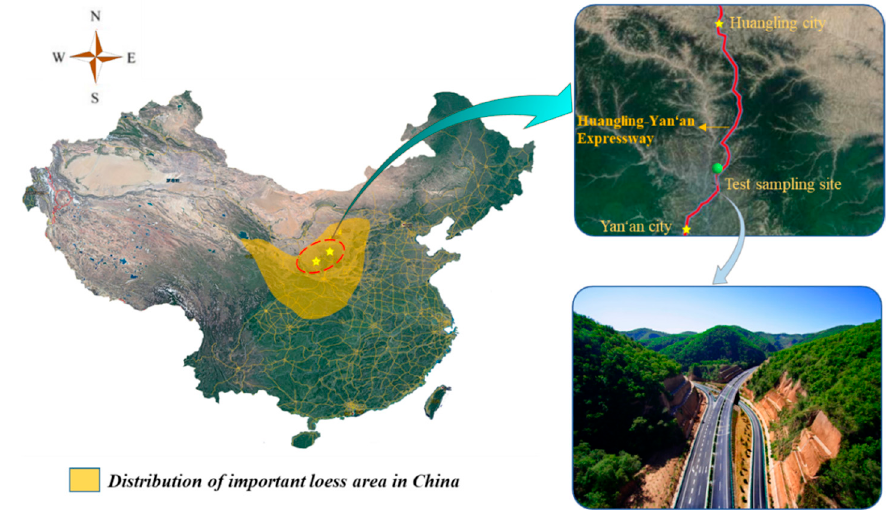
Figure 2. Location of research.